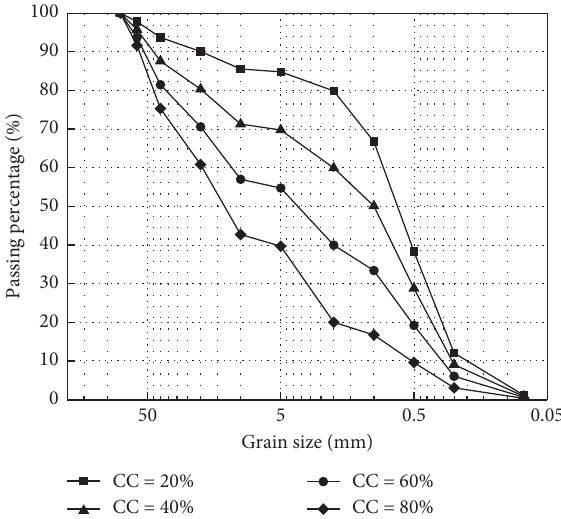
Figure 2: Grain size distribution of sand and cobble soil.